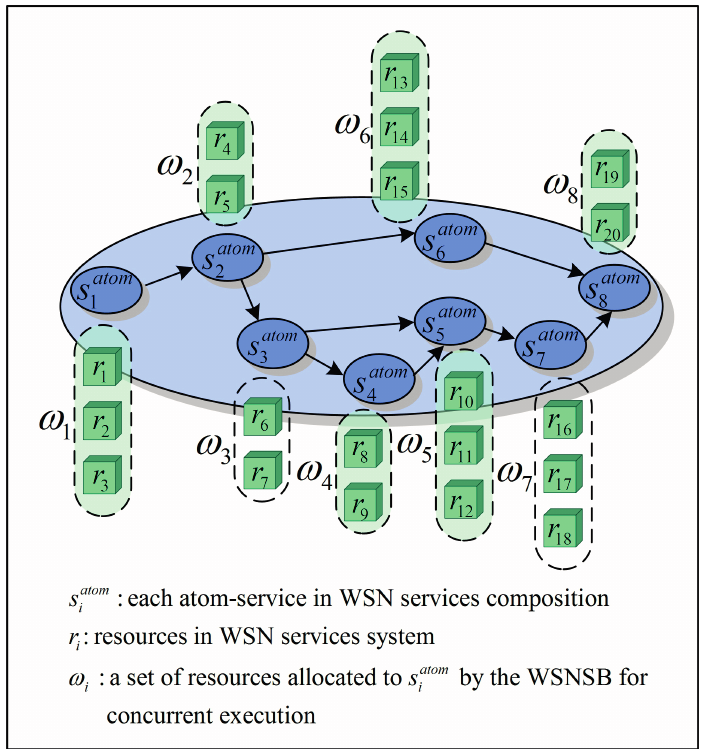
Figure 3. Resource allocation for ASs by the